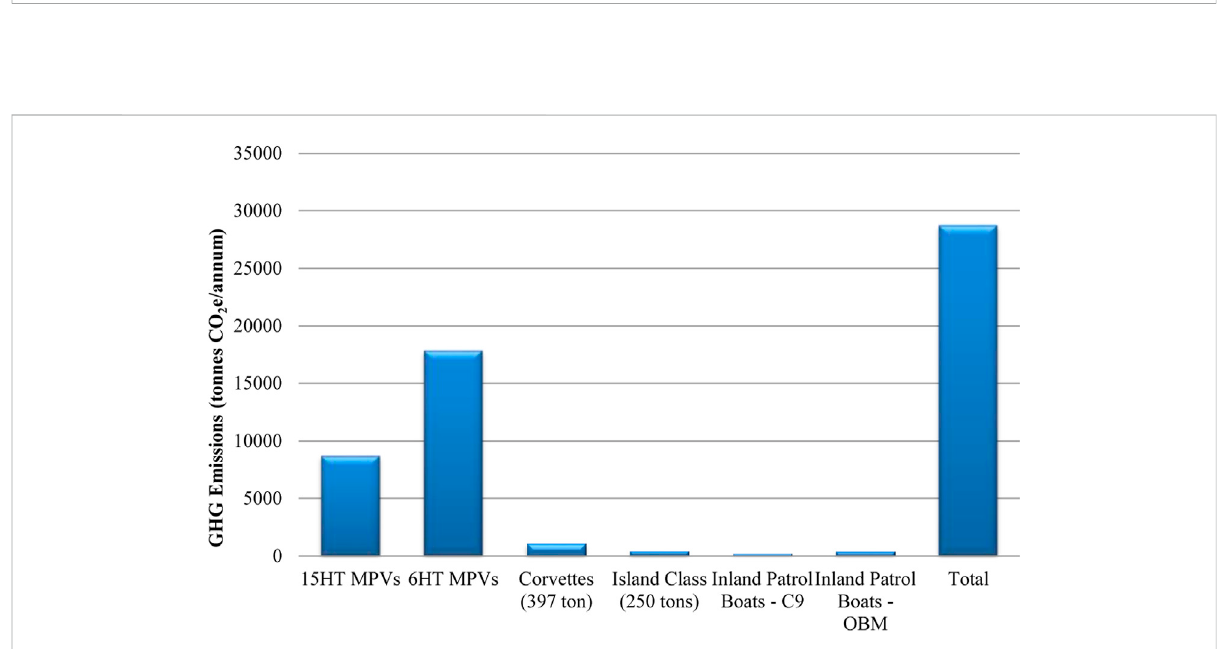
FIGURE 7 Total annual GHG emissions (CO 2 e) from PMSA fl